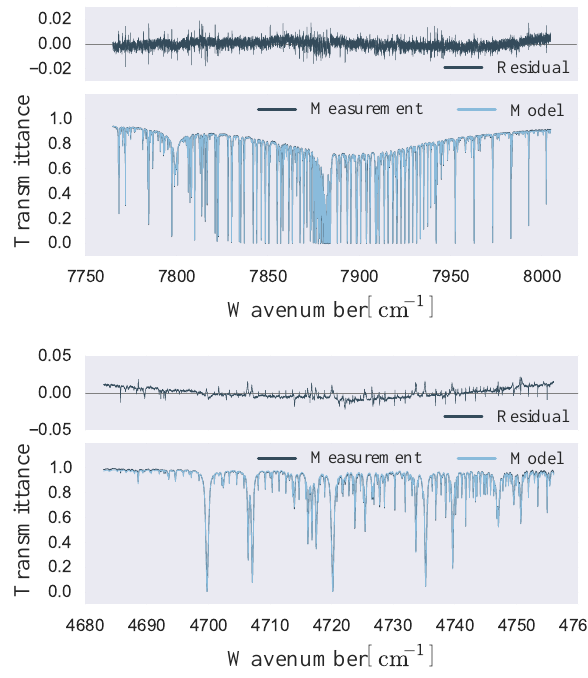
Figure 2. Spectral fits for a particular Karlsruhe spectrum: upper panel, spectral fit and residual for O 2 (cw: 7885.0); lower panel, spectral fit and residual for N 2 O (cw: 4719.5).